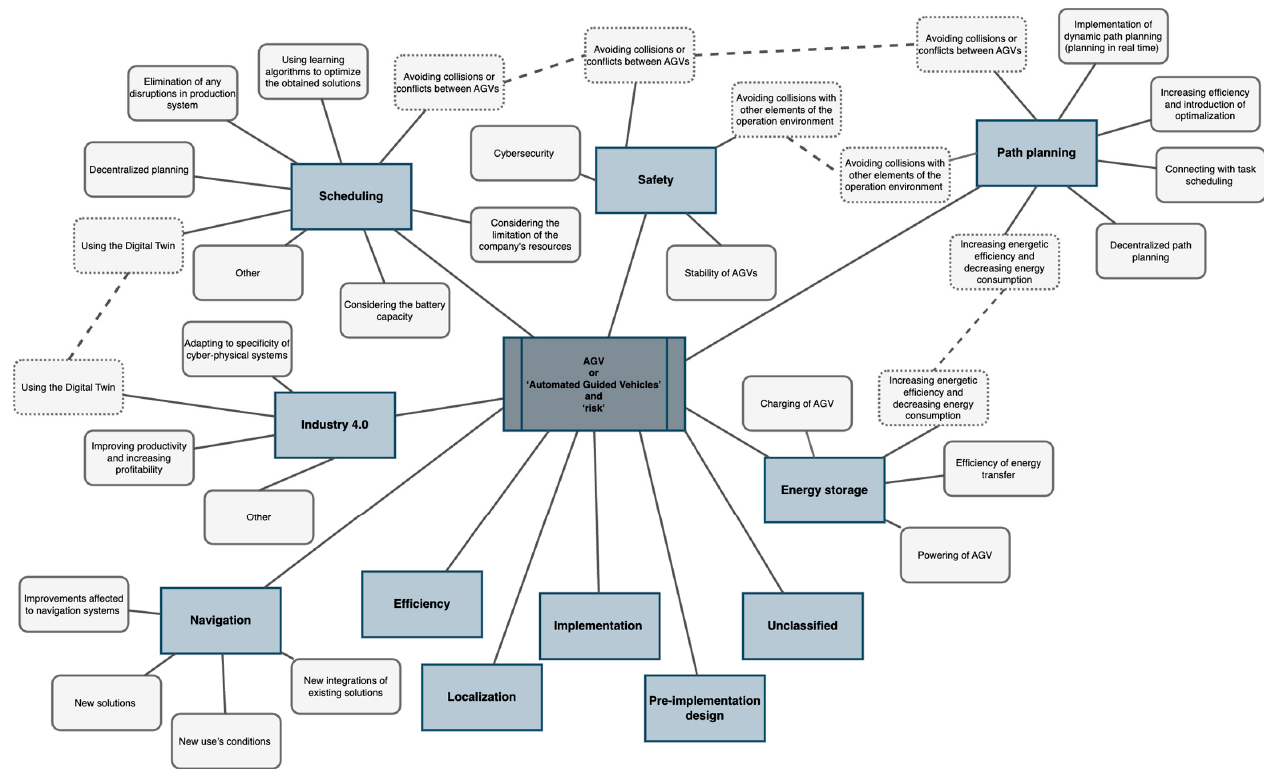
Figure 9. Articles divided into primary categories and subcategories. Table 3. Articles divided into primary categories and subcategories .